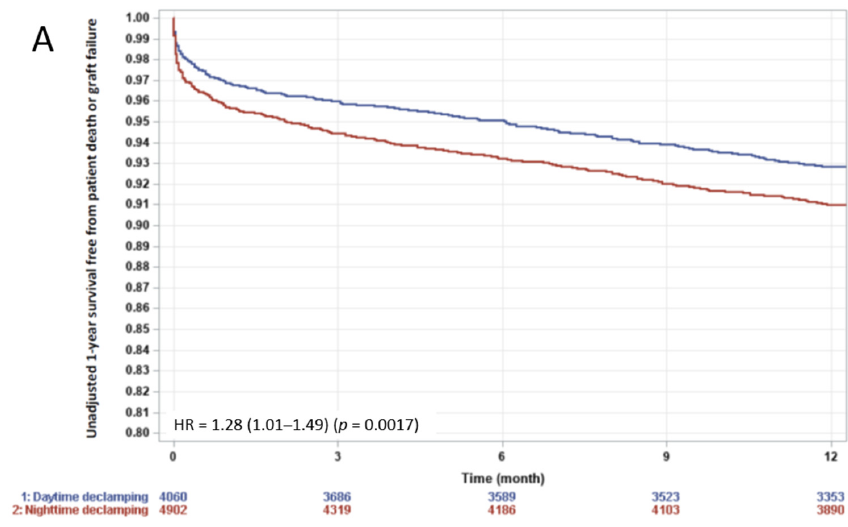
Figure 2. Non-adjusted 1-year survival according to clamping ( A ) and declamping ( B ) time-of-the-day. Patients were grouped by 2-h intervals according to clamping ( A ) or declamping ( B ) time-of-the-day. Square symbols: Incidence, p - value, and solid line by cosine function with period of 24 h by sinusoidal regression model, dashed lines: 95% confidence